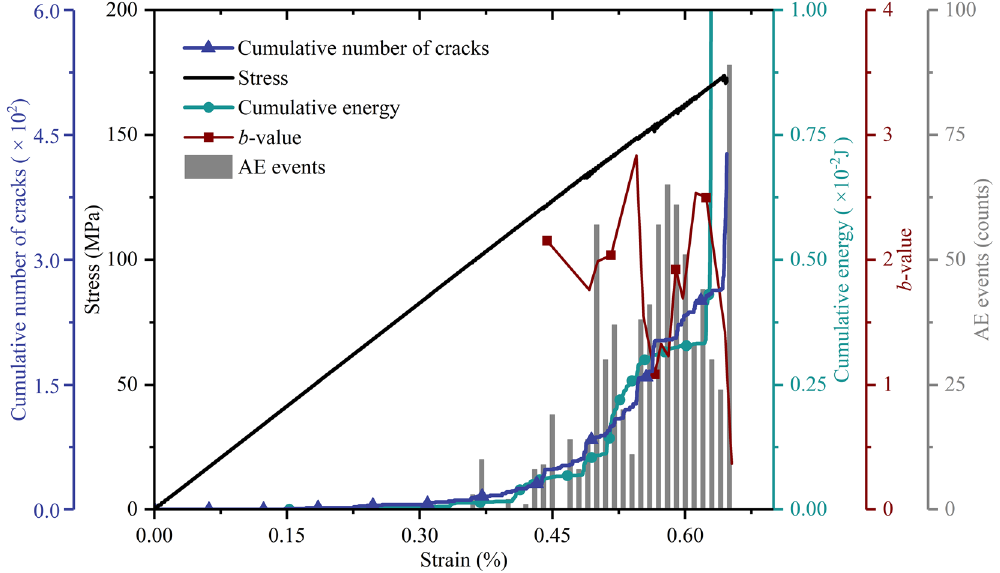
Figure 11. Axial stress, cumulative number of cracks and simulated AE parameters (cumulative energy, b -value and AE events) versus axial strain at AE sensor #d by